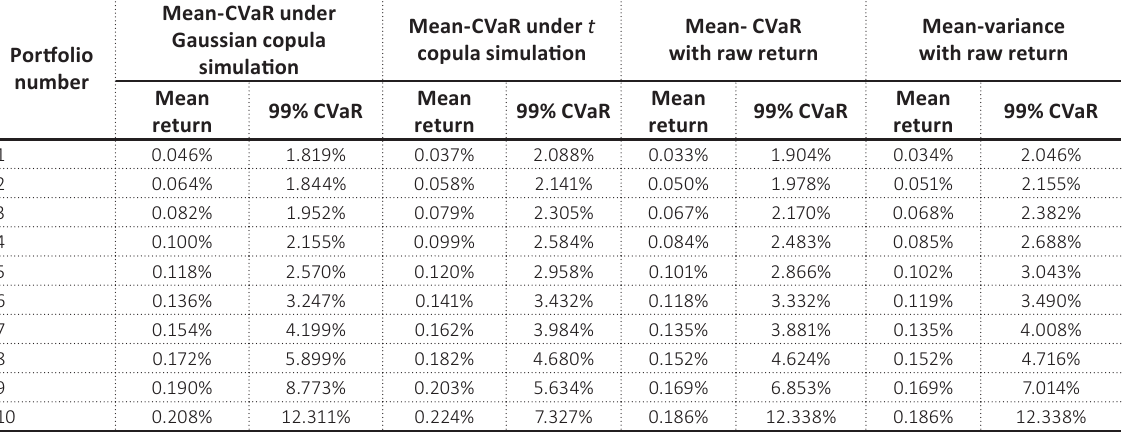
Table 4. Mean returns and 99% CVaR of 10 portfolios in each case Portfolio number